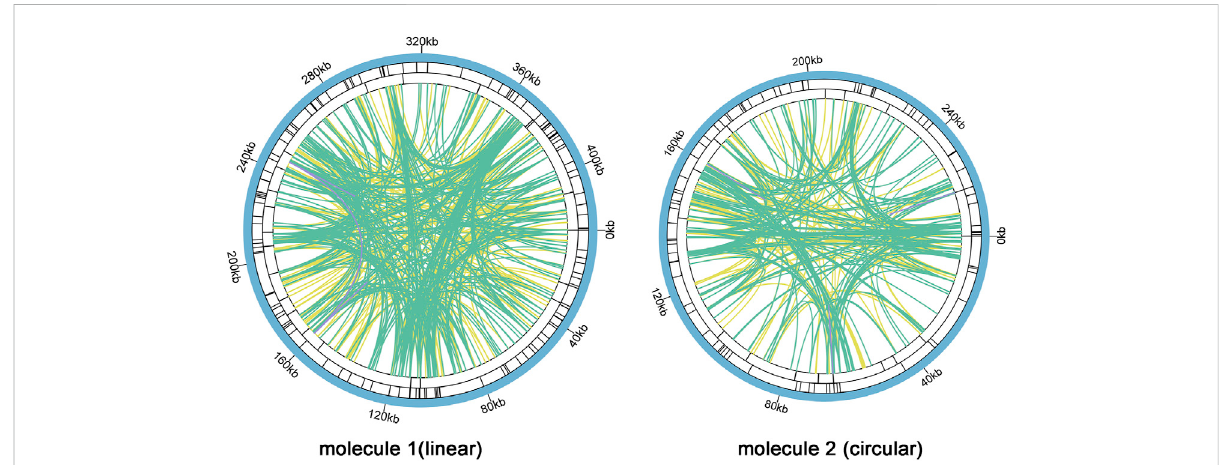
FIGURE 5 C. acerifolia mitogenome repeatedsequence diagram. Two mitochondrial molecules were analyzed separately forrepetitive sequences (one linearandonecircular),taking thelinearmolecule1asanexample.Forexample,thecoloredlinesontheinnermostcircleconnectthetworepetitive sequences of TEs, the green line represents Palindromic Match (P), the yellow line represents Forward Match (F), and the purple line represents Reverse Match (R). The black line on the second circle represents TRs, and the black line on the outermost circle represents SSRs. molecule 2 and so